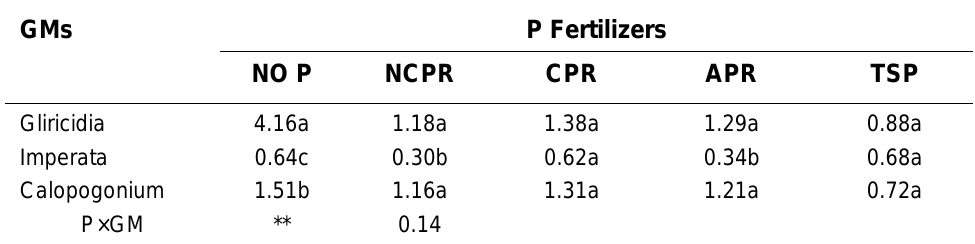
Percent of total P uptake derived from 33 P labeled GMs by Setaria sphacelata grown for 20 weeks in a tropical soil treated with GMs and P